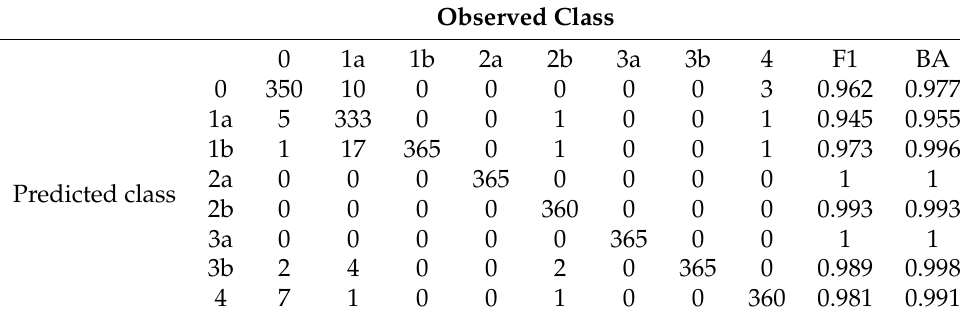
Table 3. Confusion matrix for multi-class classification for the RF model.